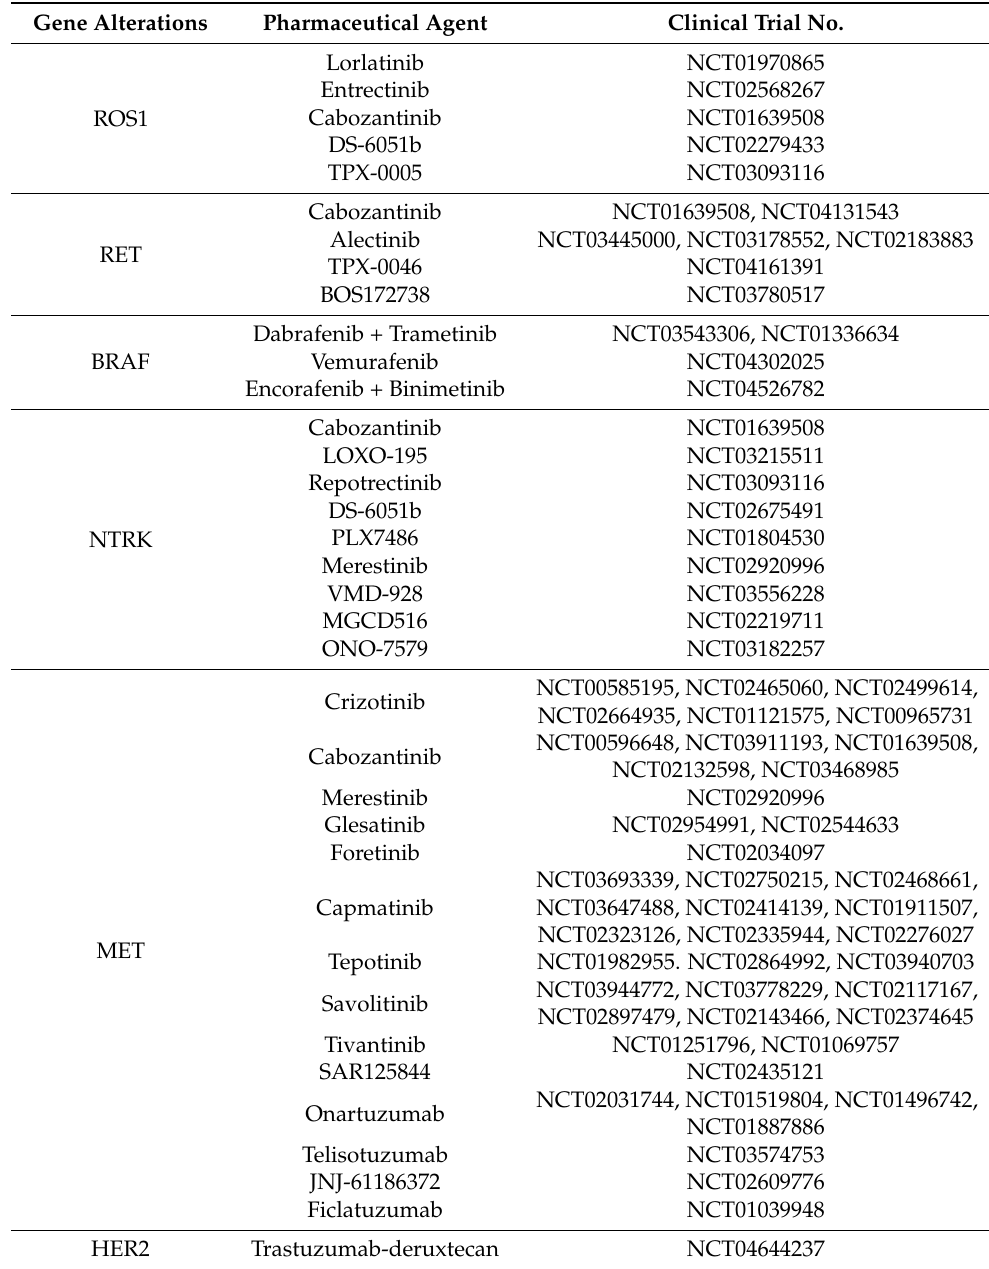
Table 2. Ongoing clinical trials to treat NSCLC mutations